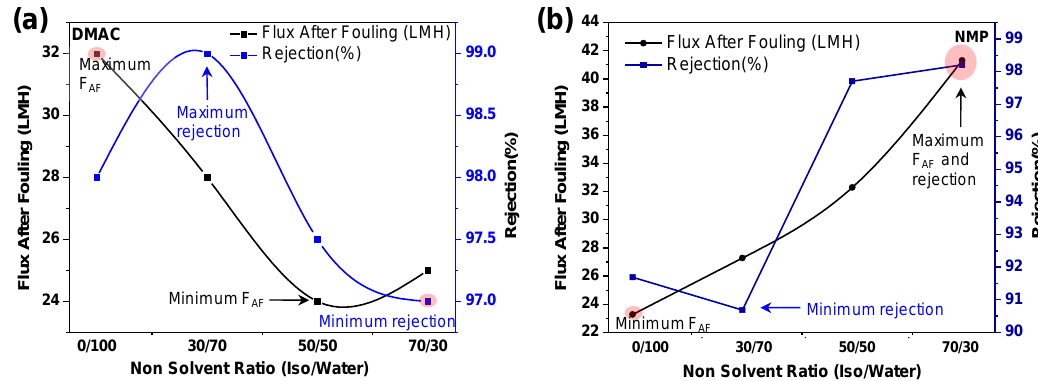
Figure 6. The effect of choosing various nonsolvent ratios on the flux after fouling (F AF ) and rejection of ( a ) PES-DMAc membrane (filtration of bovine serum albumin (BSA) 0.5 wt%) and ( b ) PES-NMP membrane (filtration of BSA 0.5 wt%).